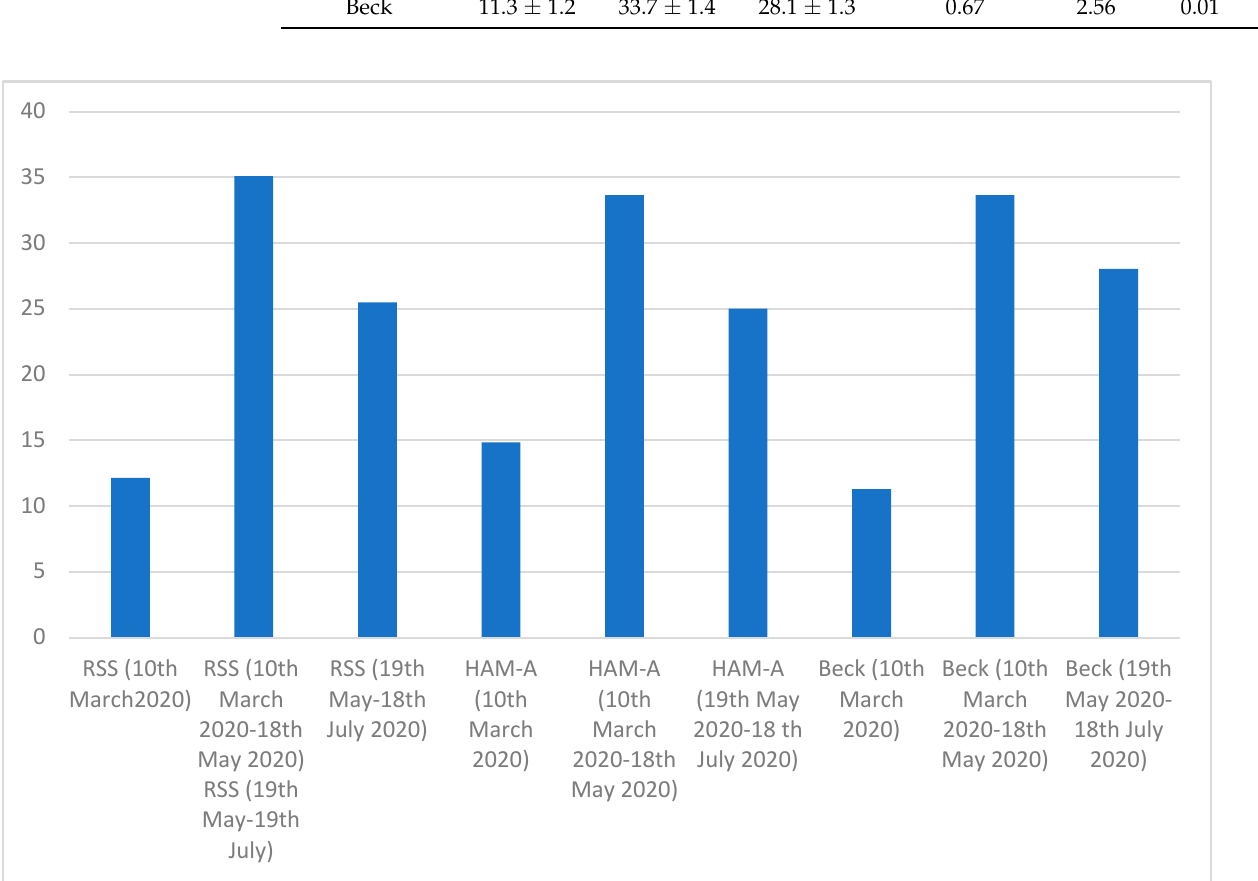
Figure 1. Graphical Assessment of the Caregivers behavioral alterations during the